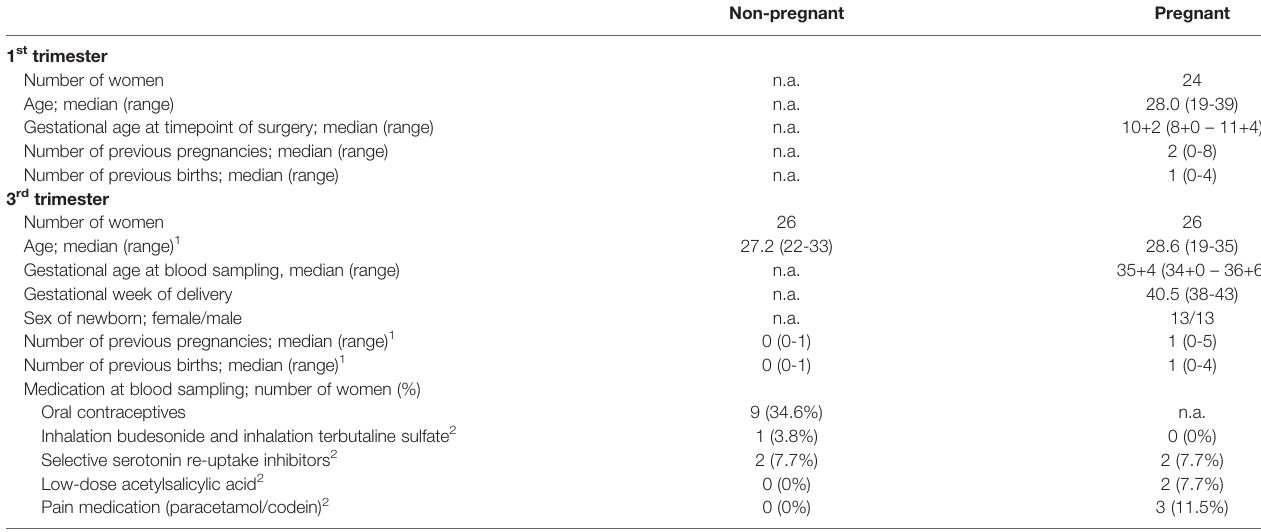
TABLE 1 | Characteristics of study participants. n.a. not